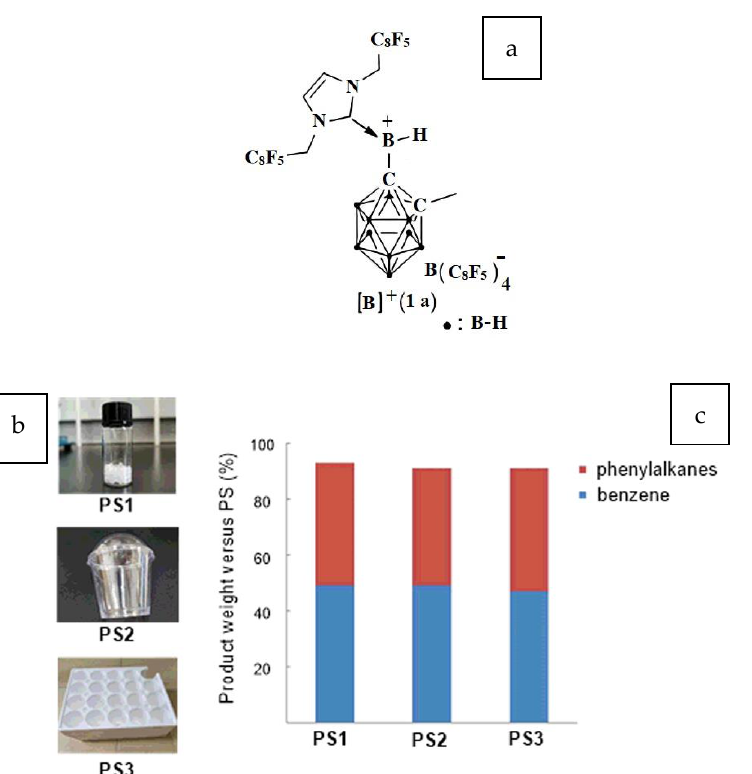
Figure 11. Hydrogenolysis of PS with ( a ) catalyst, ( b ) PS1: laboratory-grade polystyrene; PS2: polystyrene single-use cup; PS3: EPS foam (0.1 g PS + 0.05 mmol catalyst, 10 mL o-C 6 H 4 F 2 , 5 bar H 2 ). ( c ) Phenylalkane and benzene yields. Reprinted with permission from ref. [42].